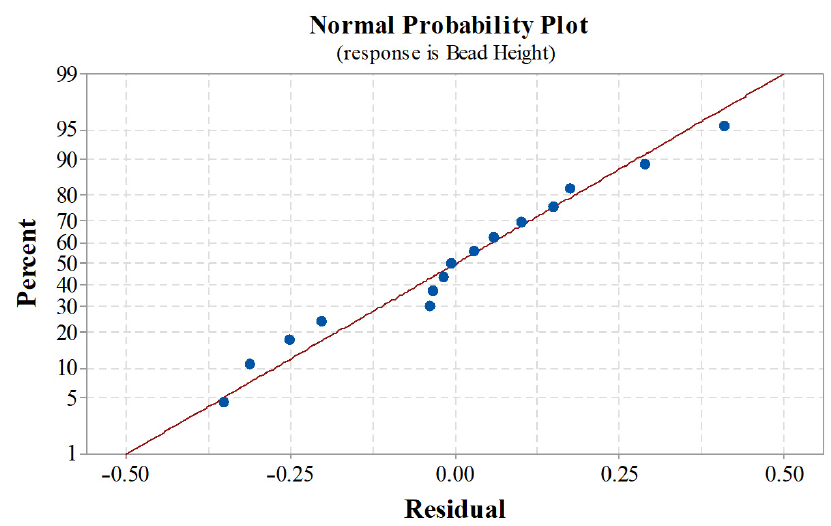
Figure 5. Normal probability plot for bead width.